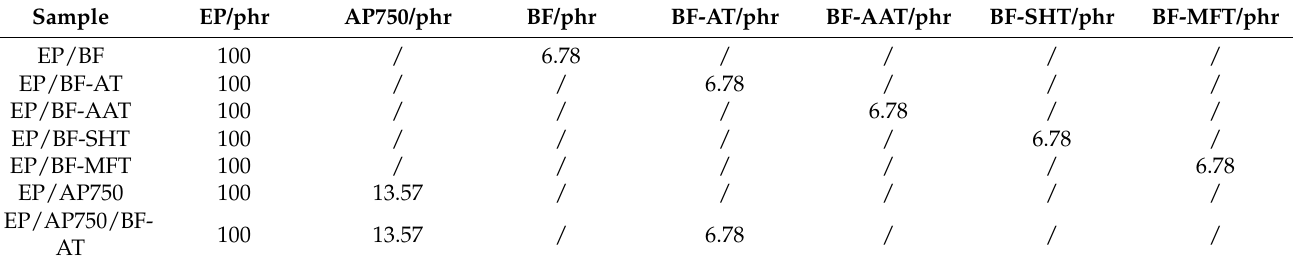
Table 1. Formulations of epoxy resin (EP)/basalt fiber (BF)-based